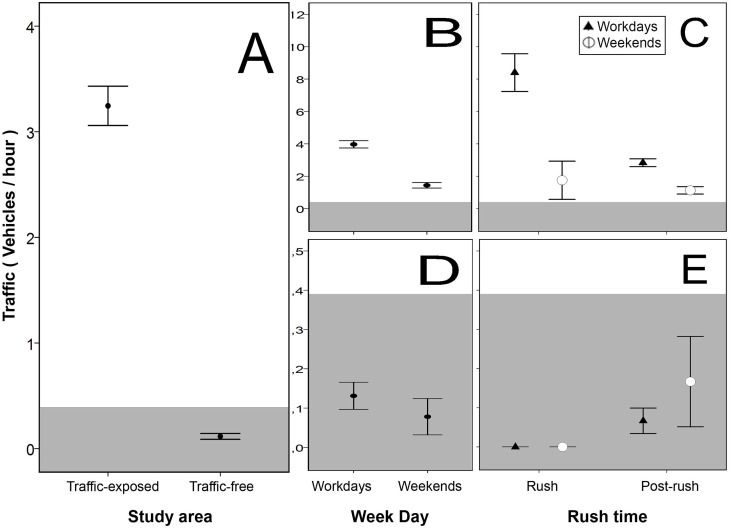
Spatio-temporal variability in daytime traffic intensity (vehicles per hour between 07:00 and 22:00h).(A) Average values in traffic-exposed and traffic-free areas. Traffic intensity across week days and according to rush time are presented separately for traffic-exposed (B-C) and traffic-free (D-E) areas. For ease of interpretation, the grey background indicates traffic intensity below 0.4 vehicles per hour. Bars represent means ±SE.